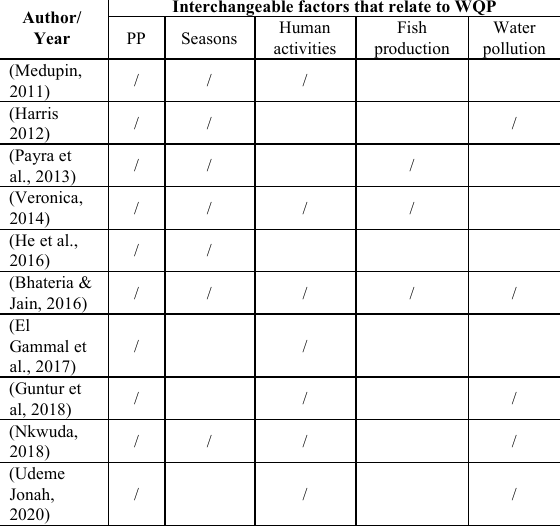
Table 1. Interchangeable factors in relation to WQP based on prior